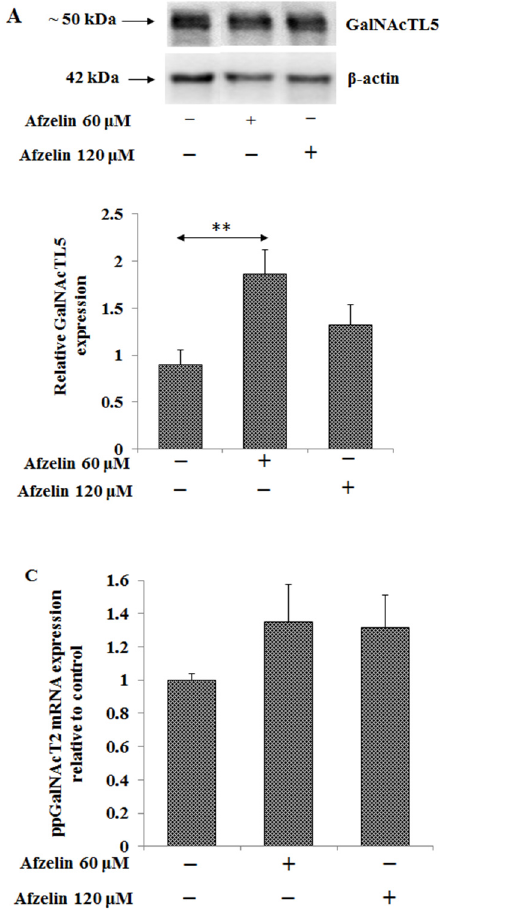
Figure 7. Effect of afzelin on the expression of enzymes taking part in Tn (GalNAc α 1-O-Ser/Thr) and T (Gal β 1-3GalNAc α 1- O-Ser/Thr) antigens formation in AGS gastric cancer cells treated with 60 and 120 µ M afzelin. Expression of GalNAcTl5 ( A ) and C1GalT1 ( B ) in cell lysates was measured using Western blot analysis. The β -actin expression served as protein loading control. The bands intensity was quantified by densitometry. Data are presented as the mean ± SD from 3 assays. * p < 0.05; ** p < 0.01; ppGalNAcT2 ( C ) and C1GalT1 ( D ) gene expressions were determined by RT-PCR. The results are shown as a relative fold change in ppGalNAcT2 and C1GalT1 mRNA in comparison to control where expression was set as 1. ± SD are the mean of triplicate cultures.